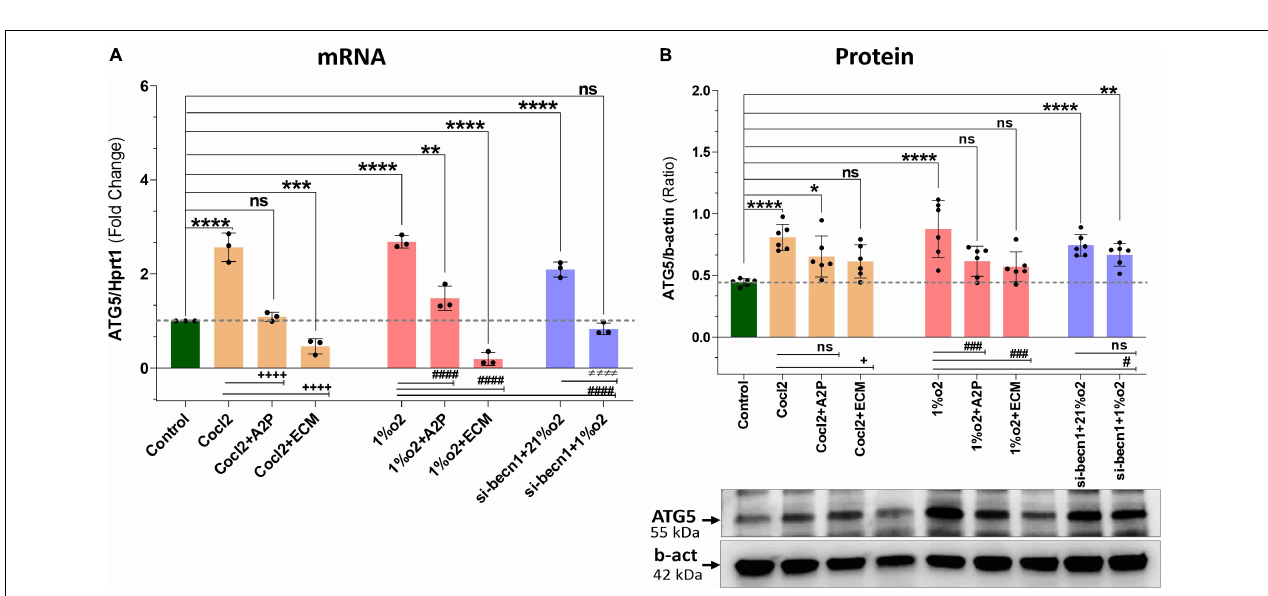
FIGURE 7 | (**** p < 0.0001). Compared to Cocl2 exposed cells, Cocl2 + A2P cells Hif1 α protein expression levels was decreased ( ++++ p < 0.0001). Also, compared to Hypoxia cells, 1%O2 + A2P ( ## p < 0.0012), 1%O2 + ECM ( #### p < 0.0001), and Beclin-1 inhibition cells grown under Hypoxia ( #### p < 0.0001) expressed decreased Hif1 α Protein levels. HIF1 α downstream target VEGF and EPO protein expression levels were significantly increased in Hypoxia and in Cocl2 exposed cells, and showed reduced expression levels with A2P (anti-oxidant) and ECM (Hif1 inhibition) treatment. Beclin-1 inhibition cells grown under normoxia and in hypoxia also showed the decreased VEGF and EPO protein expression levels compared to Hypoxia and Cocl2 exposed cells. Data represents, n = 3 (mRNA), n = 7 (Hif1a protein) and n = 3 (VEGF and EPO protein) independent samples/group; Bars are mean ± S.D. Symbols * , + , # and (cid:54)= denotes significant, “ns” represents not significant by two-way ANOVA- multiple comparisons test. P-values are ns p > 0.05, * p < 0.05, ** p < 0.01, *** p < 0.001 and **** p < 0.0001 compared to Control; + p < 0.05, ++ p < 0.01, +++ p < 0.001 and ++++ p < 0.0001 compared to Cocl2; # p < 0.05, ## p < 0.01, ### p < 0.001 and #### p < 0.0001 compared to Hypoxia; (cid:54)= p < 0.05, (cid:54)= (cid:54)= p < 0.01, (cid:54)= (cid:54)= (cid:54)= p < 0.001 and (cid:54)= (cid:54)= (cid:54)= (cid:54)= p < 0.0001 compared to si-becn1 (21%O2) Vs, si-becn1 (1%O2). In western blots “ → ” represents a specific signal.